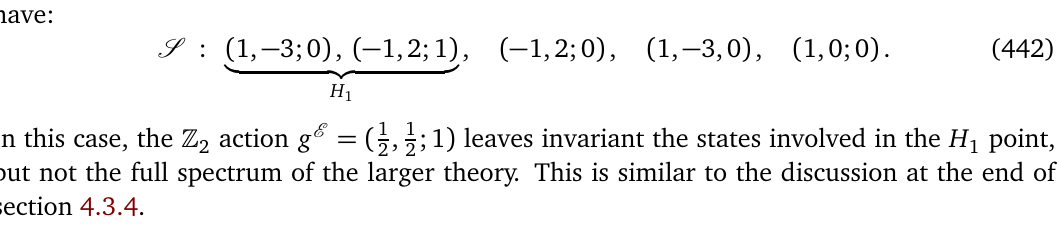
Figure 20: Fundamental domain for the ( I D E S 1 3